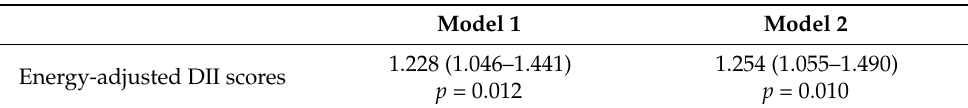
Table 6. Odds ratios (95% confidence intervals) for schizophrenia by energy-adjusted dietary inflam- matory index (DII)